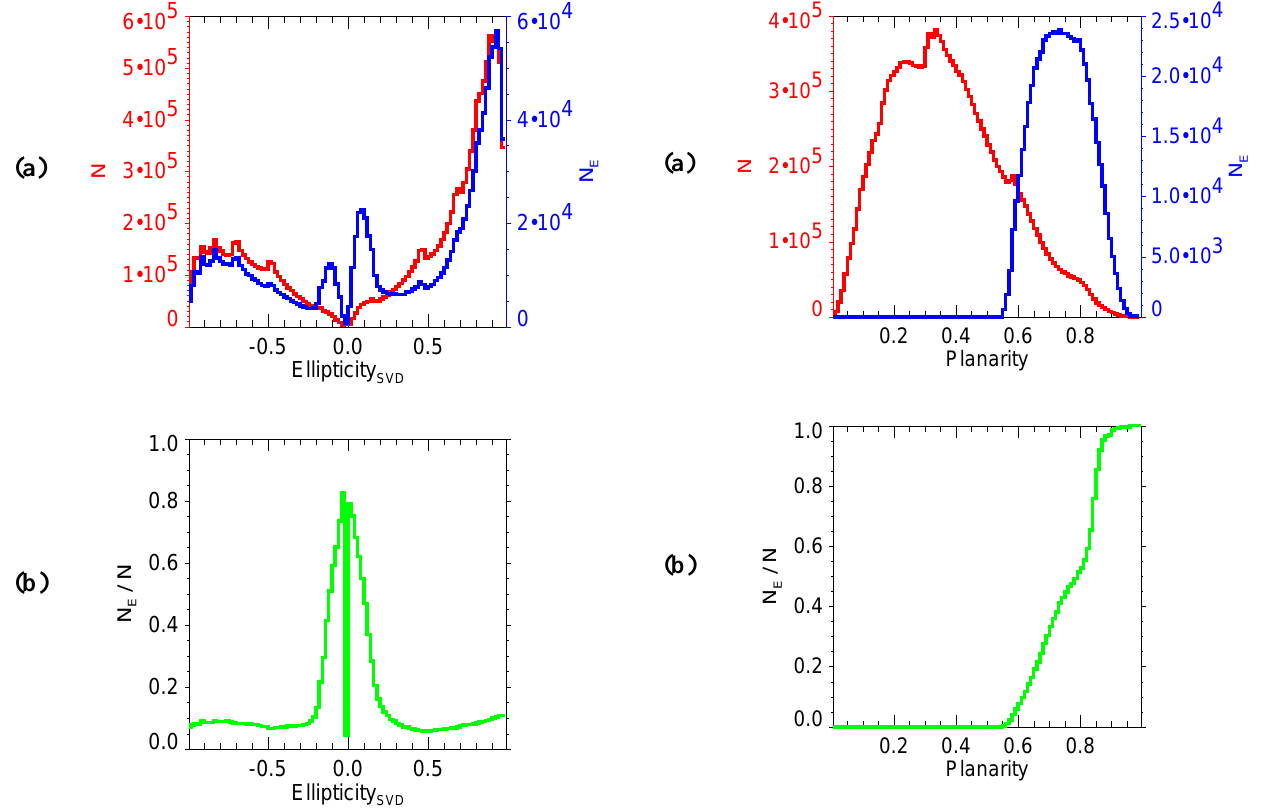
Fig. 3. Histograms of the planarity determined using the singular value decomposition of the magnetic spectral matrix. (a) Histogram for all 1.4 × 10 7 time-frequency points, plotted in red with the left- hand-side vertical scale; and for selected 5.4 × 10 5 nearly linearly polarized events with L p < 0.2, plotted in blue, with the right- hand-side vertical scale. (b) A normalized histogram for the nearly linearly polarized